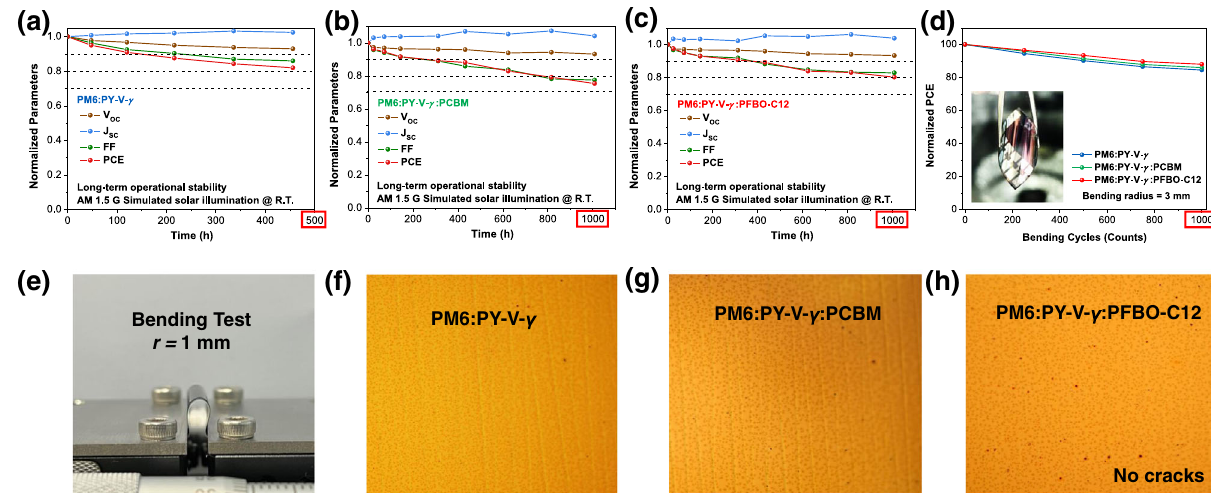
Fig. 5 | Light stability, fl exible device and mechanical test. a – c Light-soaking stabilitytestresultsoftheencapsulatedall-PSCsbasedonthreeblendsunder1-sun illuminationatroomtemperature. d Bendingdurabilitytestsofthe fl exibleall-PSCs